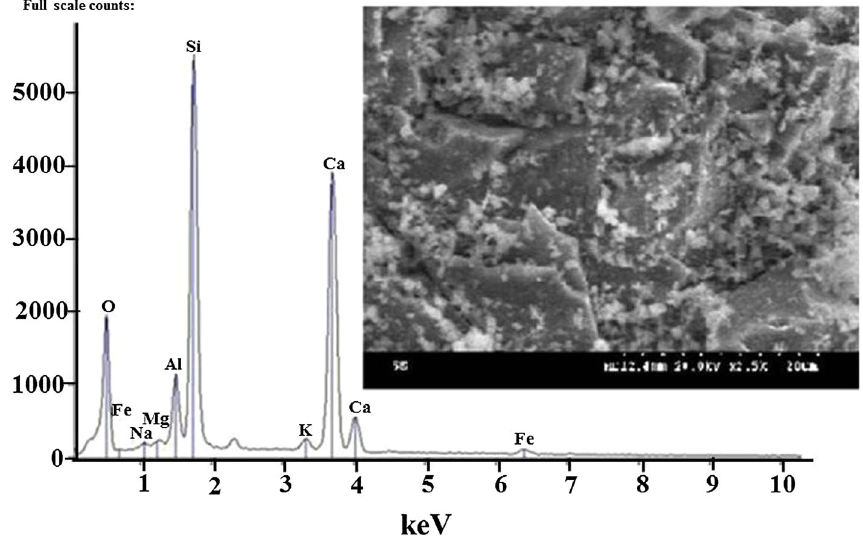
Fig. 8 SEM analysis for FRL15.